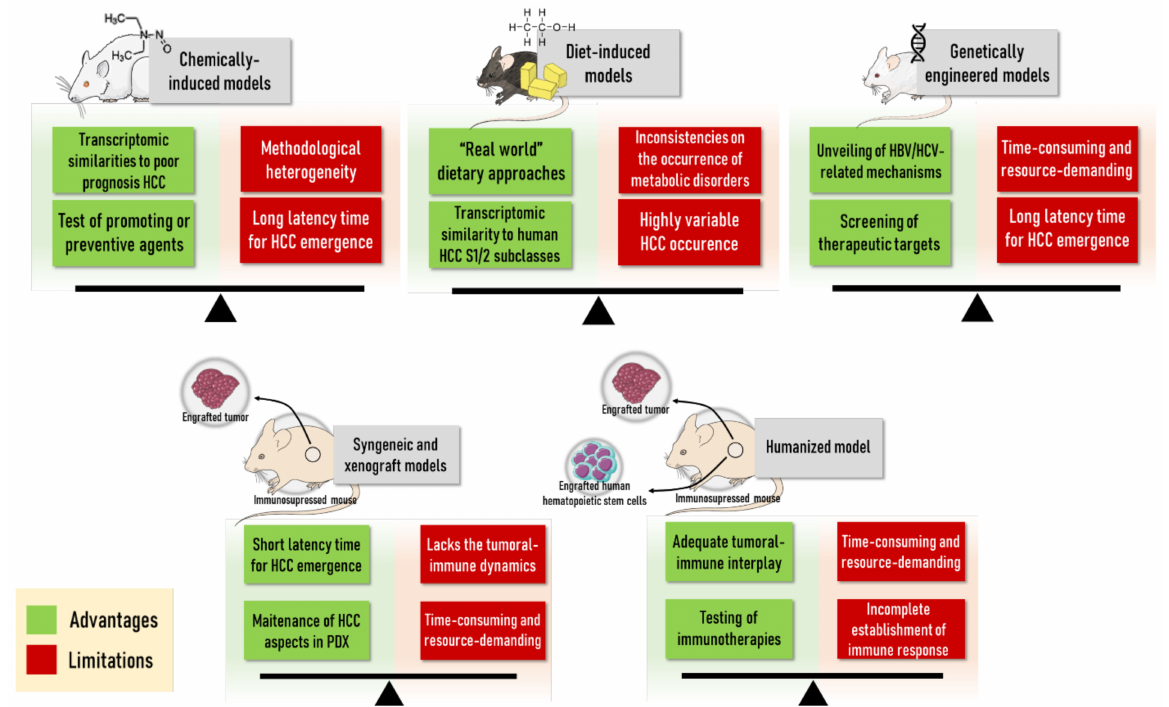
Figure 5. Main advantages and limitations of the main in vivo HCC mouse models available in the literature. The choice of the animal model must weight all the summarized aspects to provide relevant, translatable scientific data towards the understanding of hepatocarcinogenesis. The figure was composed with the aid of illustrations from the SMART-servier Medical Art available at https://smart.servier.com/ (accessed on 15 January